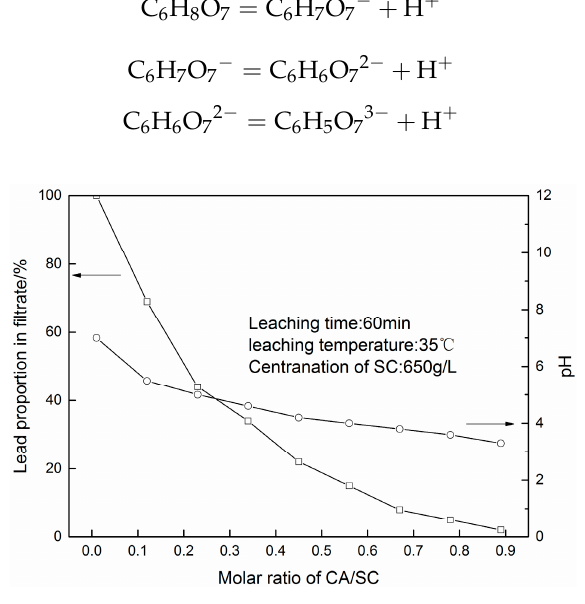
Figure 4. Lead proportion in filtrate with different molar ratios of CA/SC (leaching time is 60 min, leaching temperature is 35 °C, concentration SC is 650 g/L).